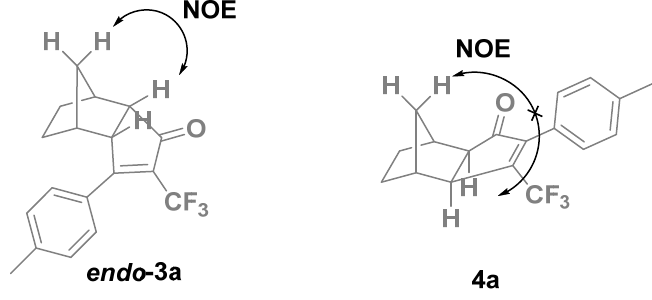
Figure 2. Characteristic NOE's for the endo diastereomers that are not present in the exo